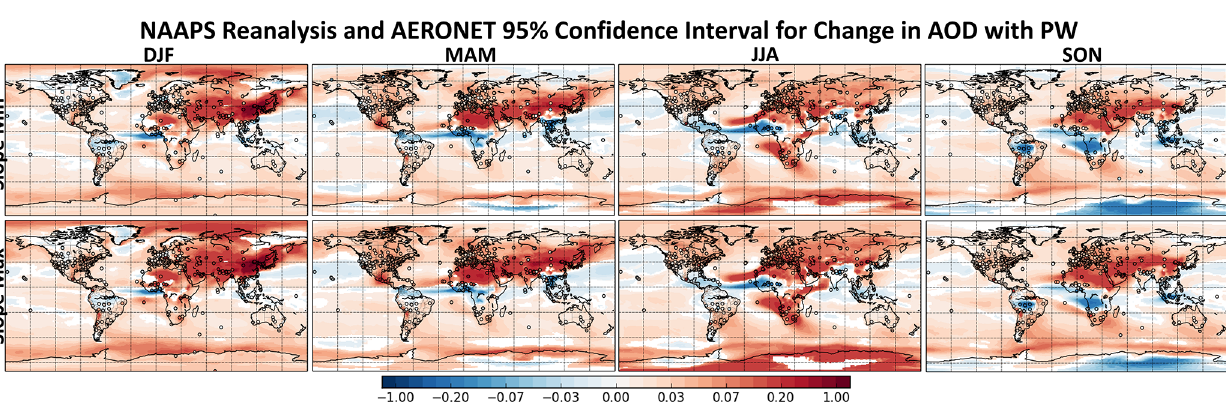
Figure 8. The 95% confidence interval in the Theil–Sen change in AOD with PW (cm − 1 ) for DJF, MAM, JJA, and SON. The confidence intervals are shown for both the NAAPS-RA and